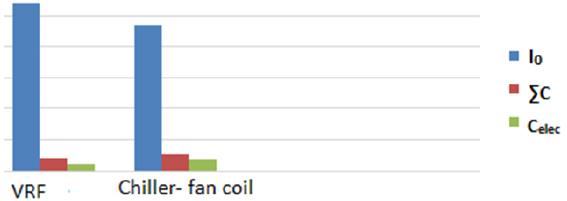
Figure 3. Graphical representation of the initial costs and subsequent servicing of air conditioning plants over a year, thousands of